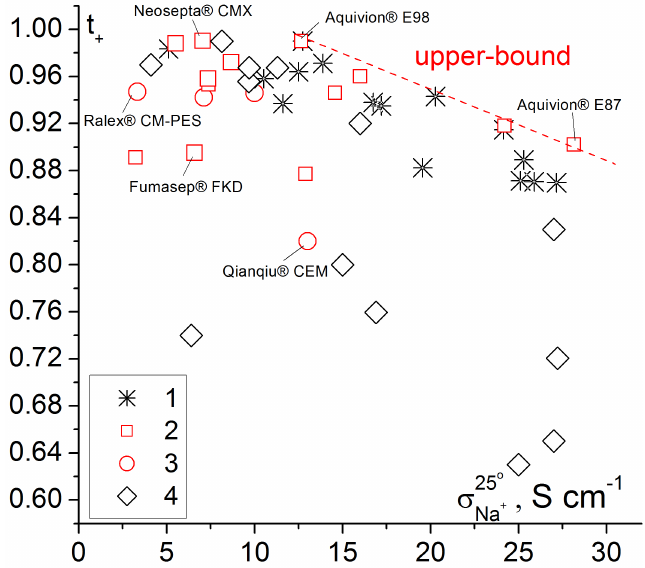
Figure 3. Dependence of apparent transport numbers (0.5 / 0.1 M NaCl) on the Na + conductivity of various cation exchange membranes. 1—grafted membranes based on